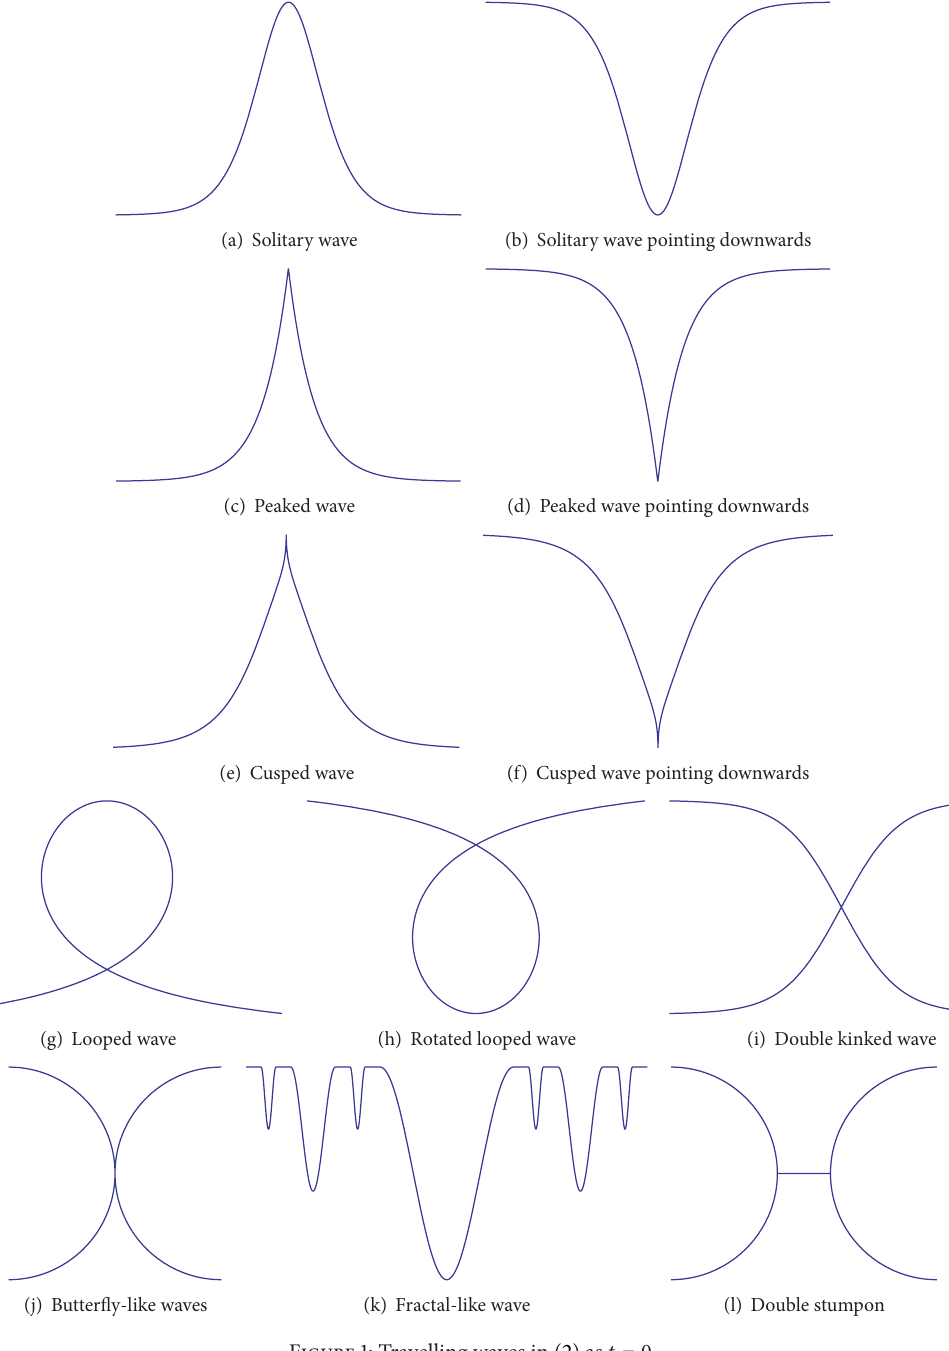
Figure 1: Travelling waves in (2) as 𝑡 = 0